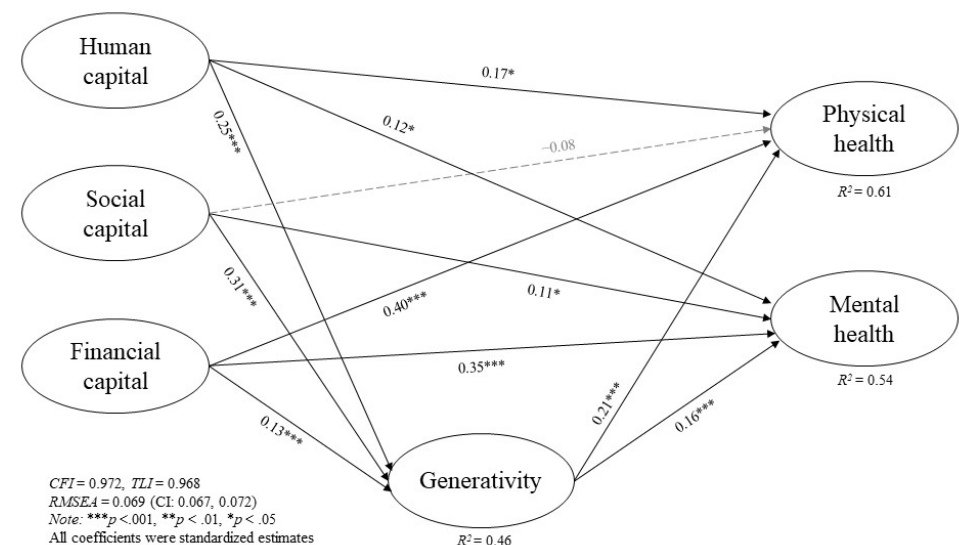
Figure 1. Effects of human, social, and financial capital on physical and mental health, mediated by generativity, total sample. Covariates were controlled for age, gender, marital status, working status, income, assets, and asset ownership. Structural standardized estimates were reported from the final structural models. Black solid lines refer to statistically significant paths; gray dashed lines refer to nonsignificant paths. *** p < 0.001, ** p < 0.01, * p < 0.05.